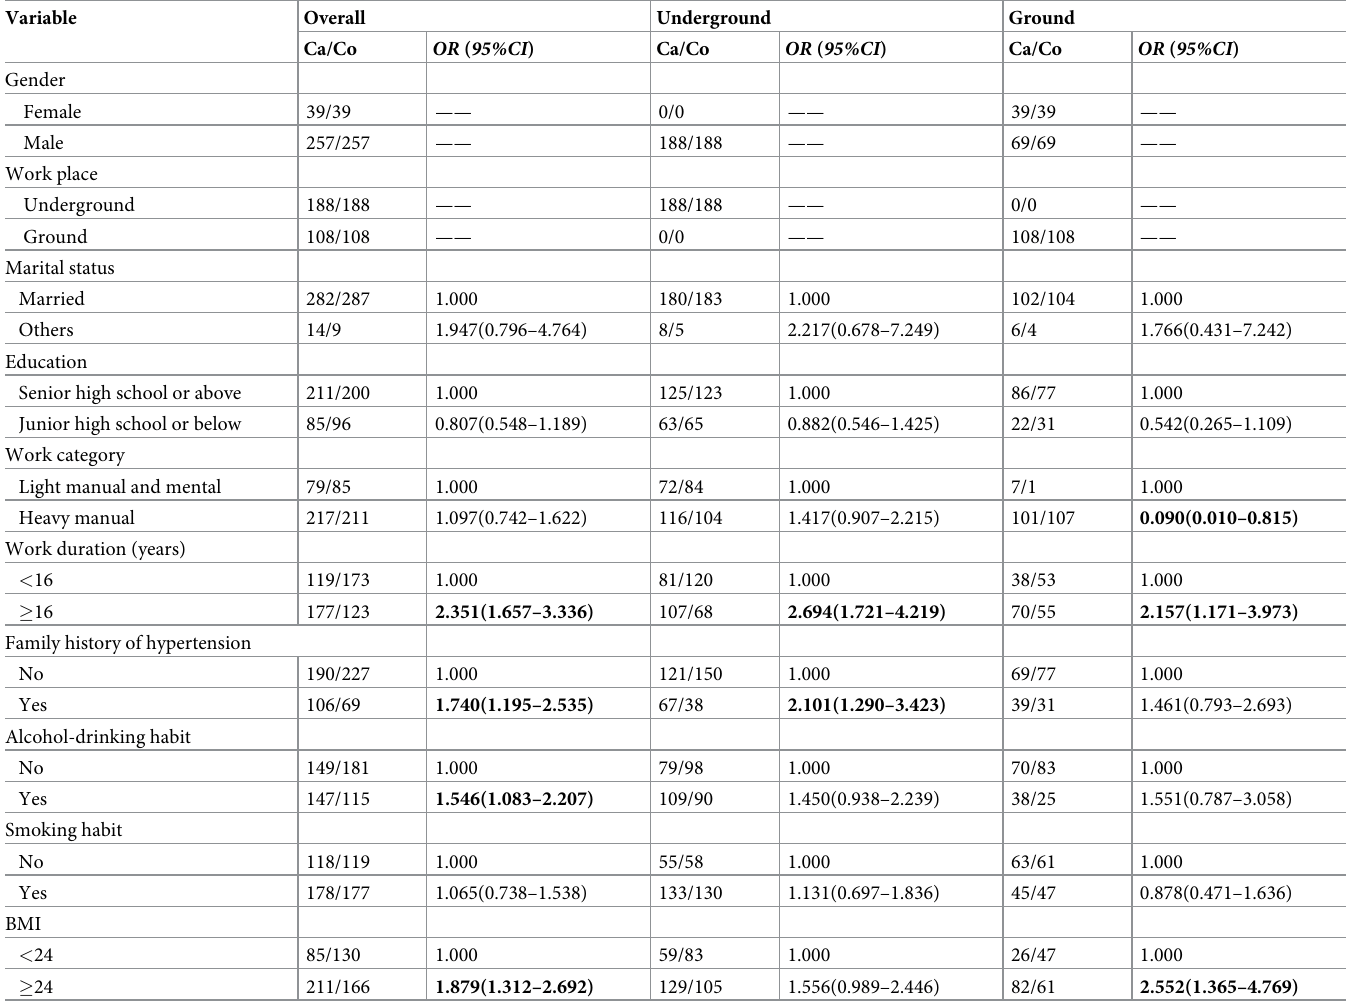
Table 2. OR s and 95%CI s of main risk factors for hypertension.